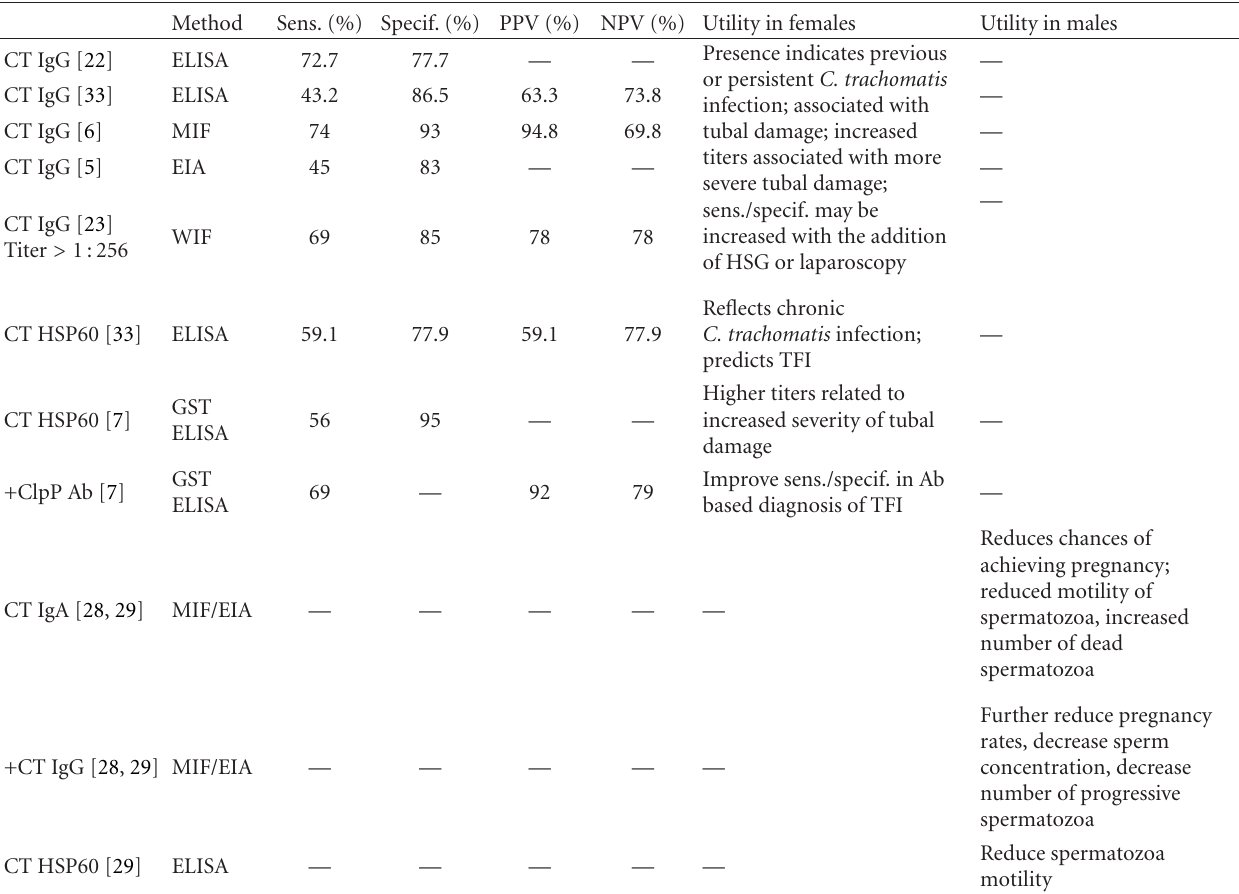
Table 1: Role of antichlamydial antibody testing in male and female